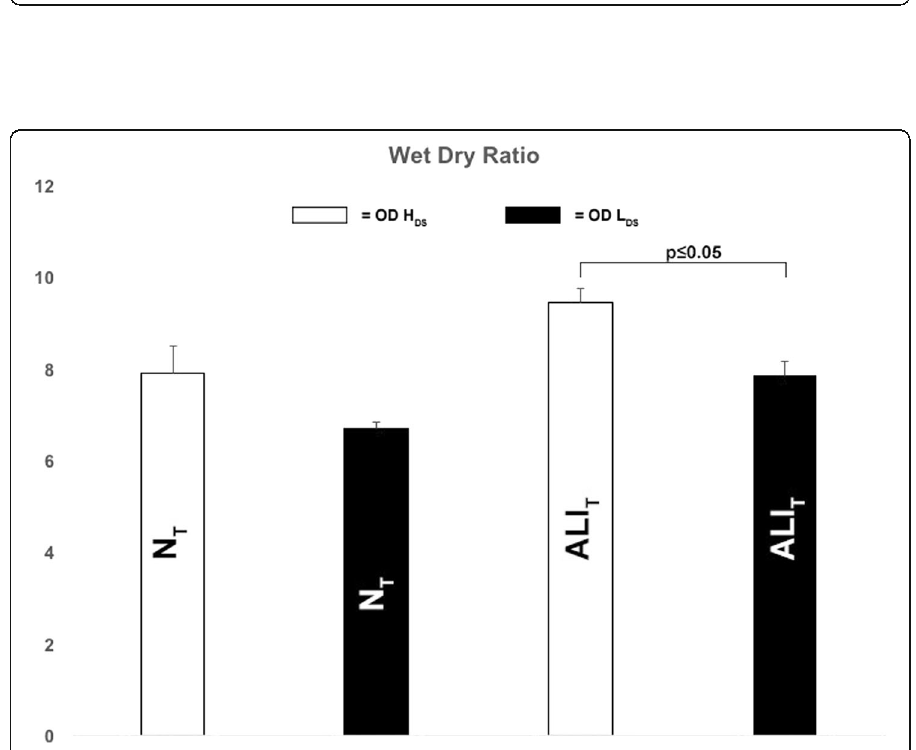
Fig. 4 Pulmonary edema measured as a lung wet/dry weight ratio following ventilation with high ( OD + H DS ) and low ( OD + L DS ) dynamic strain and in normal ( N T ) and acutely injured ( ALI T ) lung tissue. Data